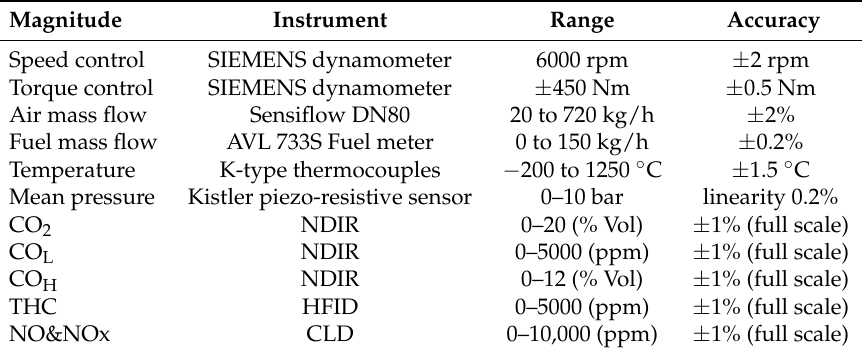
Table 2. Main characteristics of the